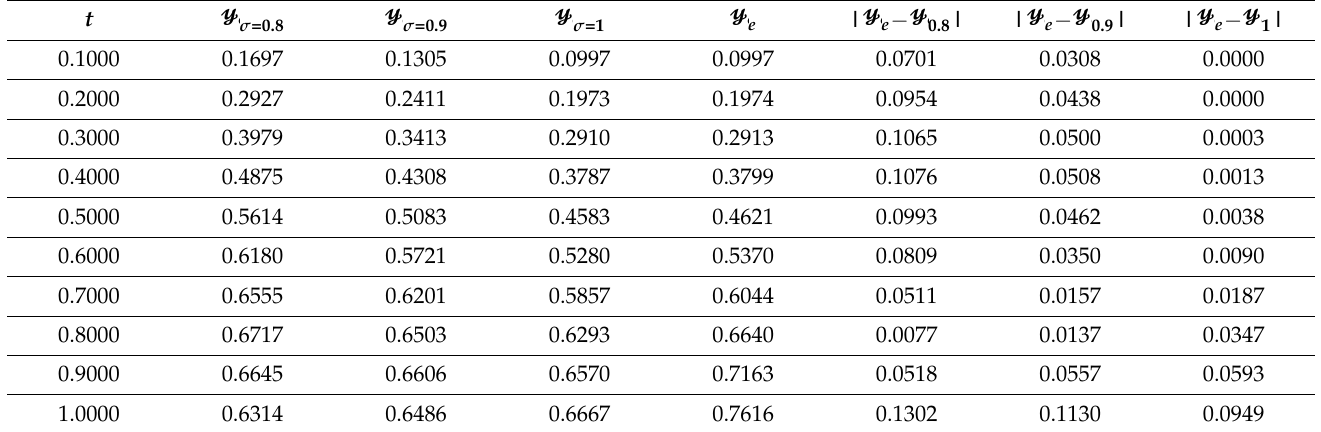
Table 1. Values of the approximate and exact solutions of Equation (19) at di ff erent values of 𝓉 .